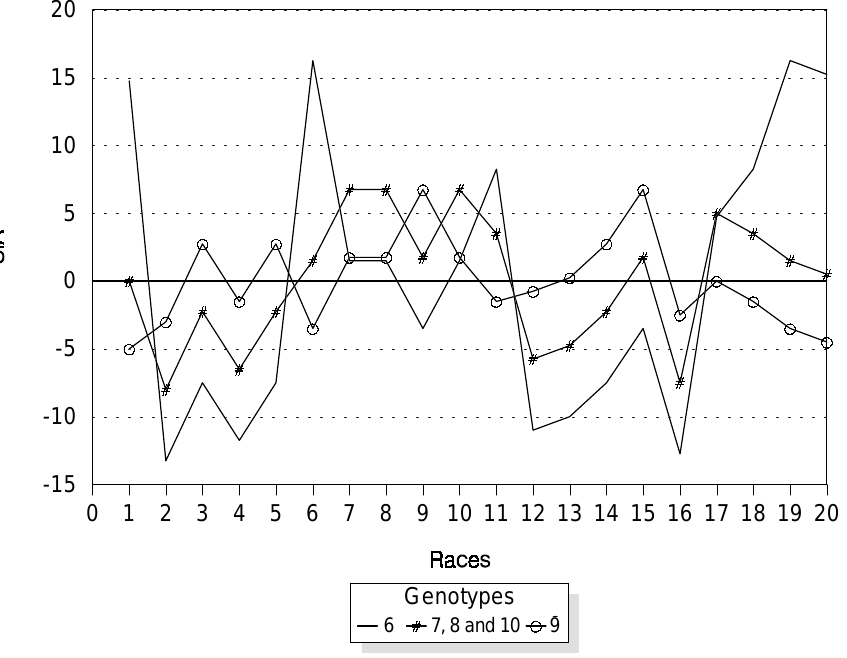
Figure 1 - Specific interaction ability (SIA) of some hosts inoculated with different pathogen races according to additive